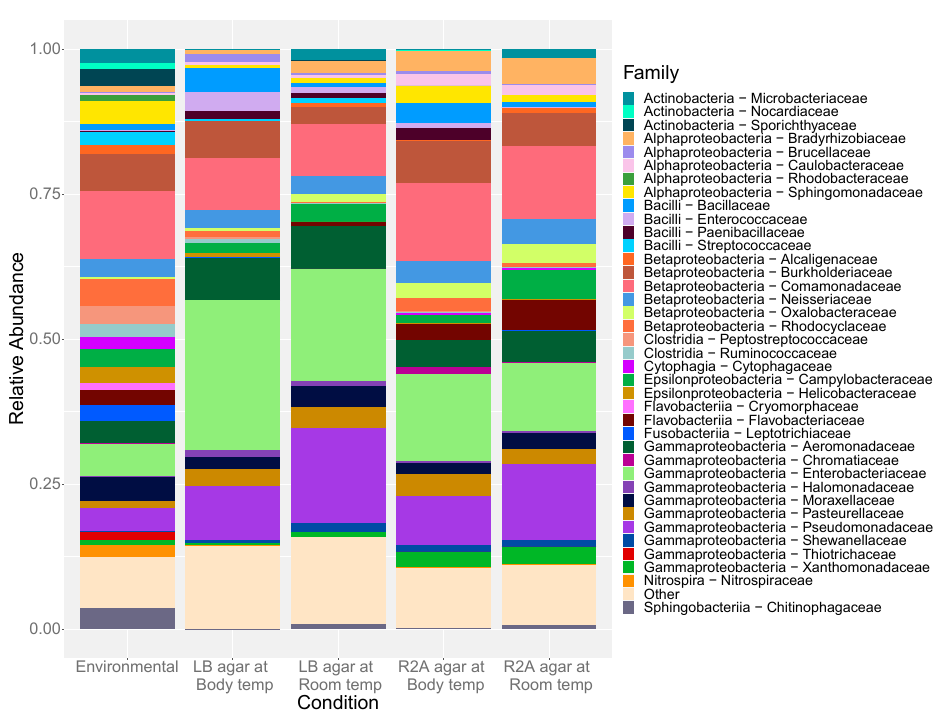
Figure 6. Relative abundance of the taxonomic families for the culture-independent samples and each culture-dependent condition. Families making up <1% of the total community at each site were excluded.